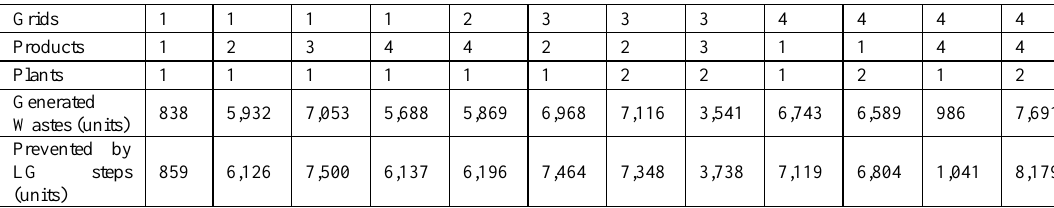
Table 6. Wastes generated in plants of typical grids that may be prevented by LG steps Grids